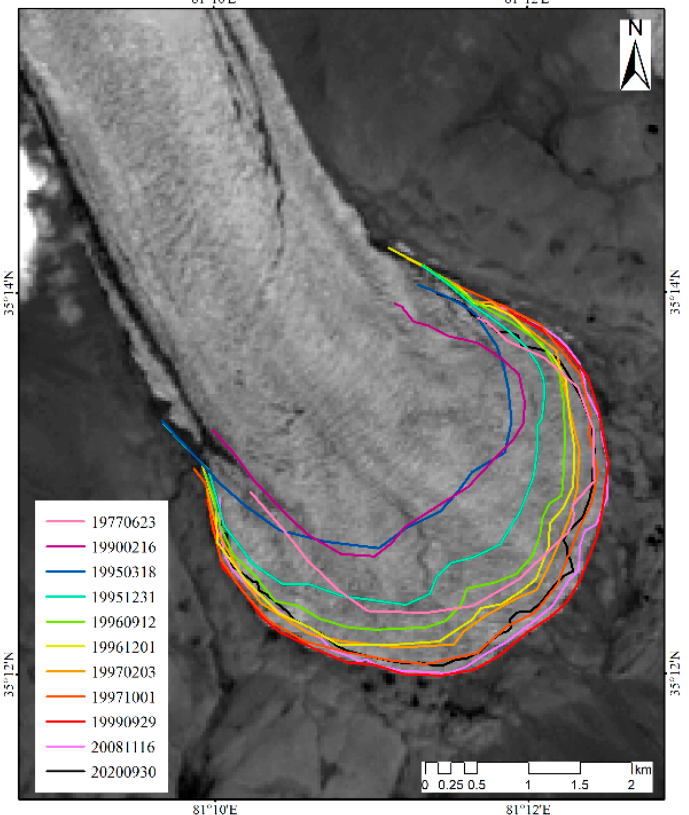
Figure 8. Changes in the boundary of the terminus of the Chongce Glacier from 1977 to 2020. The background is the Landsat ETM+ image acquired on 29 September 1999.